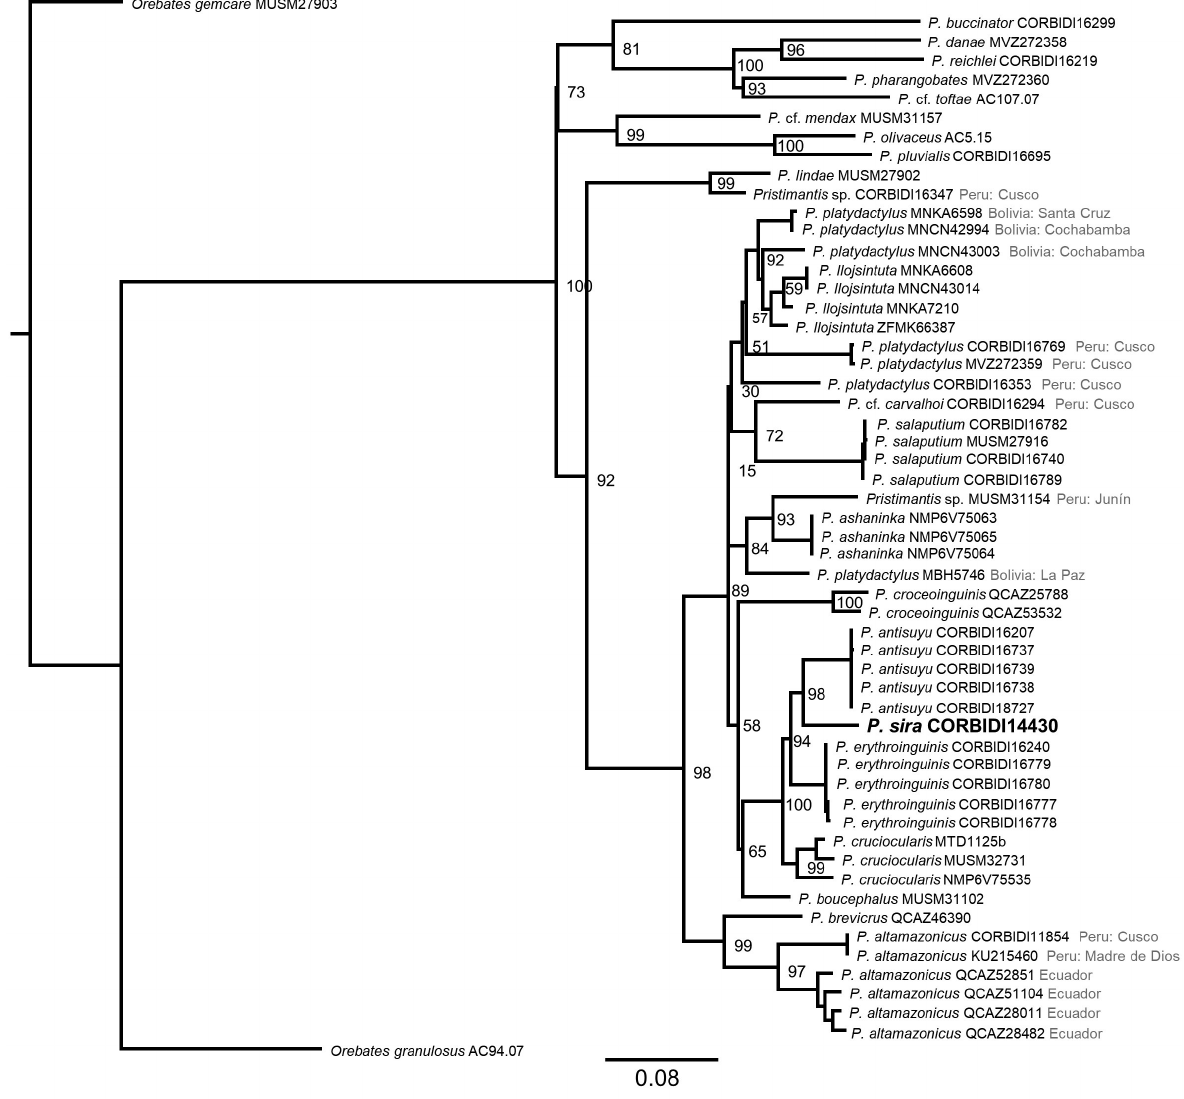
Figure 1. Phylogenetic analysis based on concatenated dataset of 16S, CO1 and RAG sequences showing the relationship between the new species (highlighted in bold) and its congeners. ML bootstrap values are indicated at each